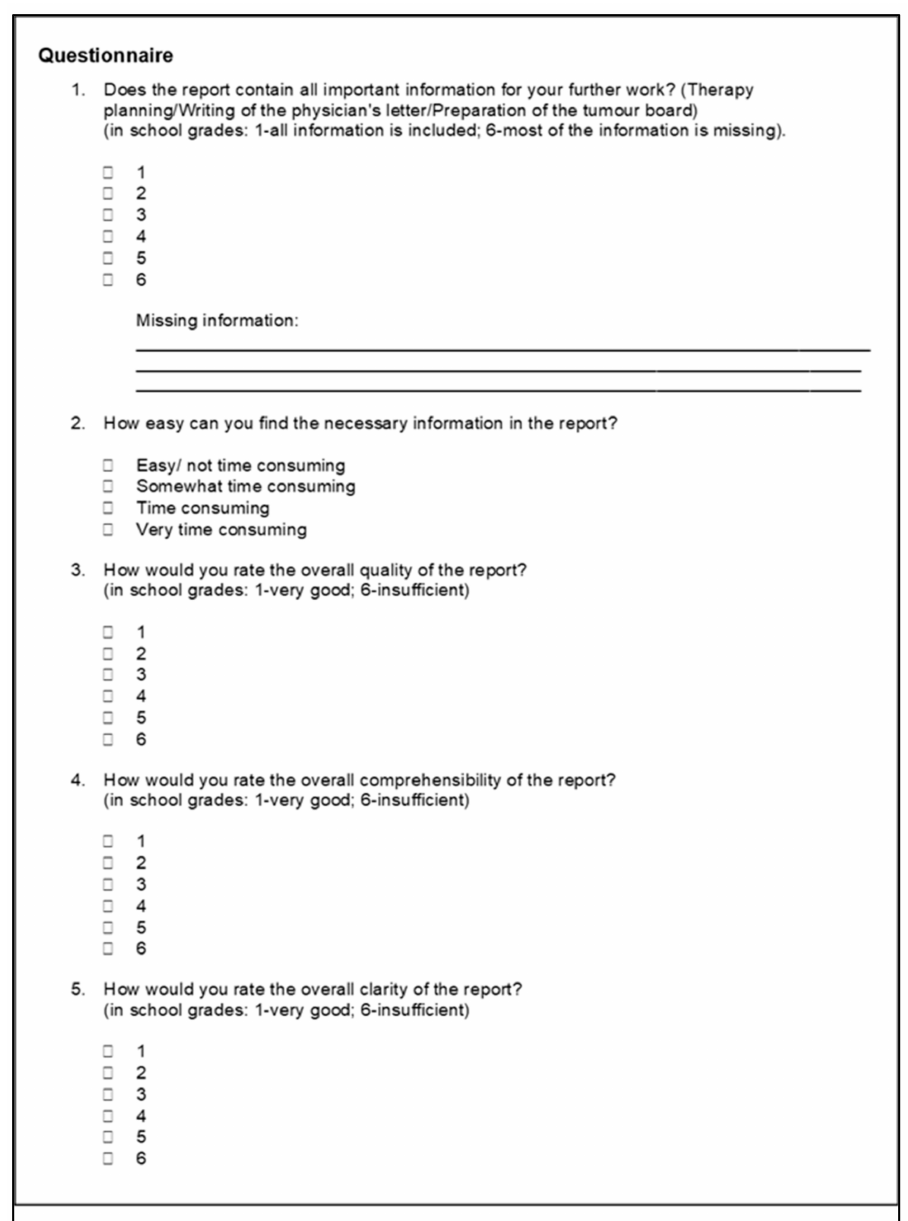
Figure A1. Questionnaire for the evaluation of narrative and structured reports addressing complete- ness, time saving, quality, comprehensibility, and